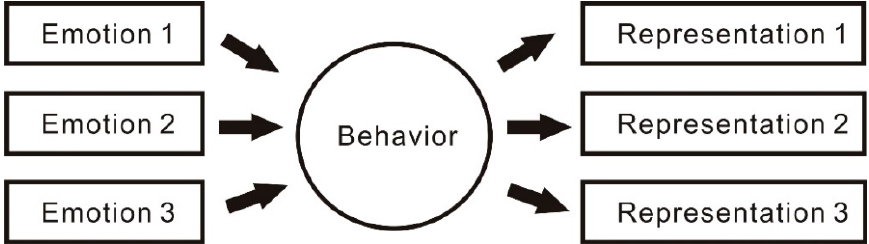
Figure 3. Schematic of emotional representation.